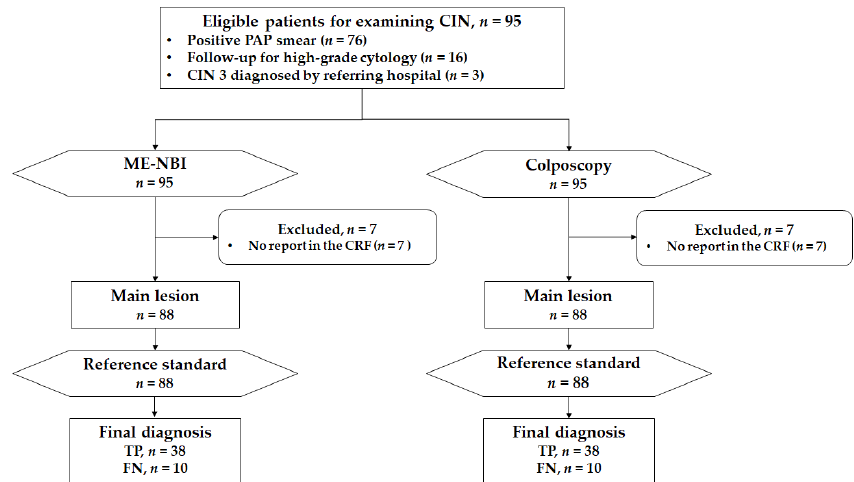
Figure 5. A STARD flow chart for primary analysis: detection ability for patients with CIN2+. TP, true positive; FN, false negative.